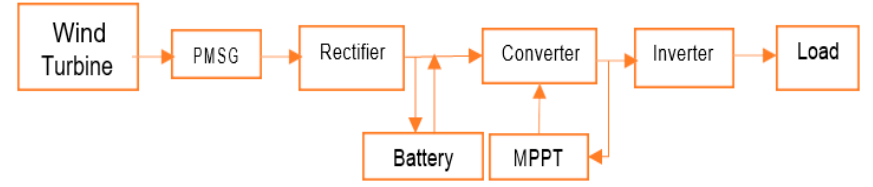
Figure 6. Block diagram of the wind turbine system with maximum power point tracking (MPPT).